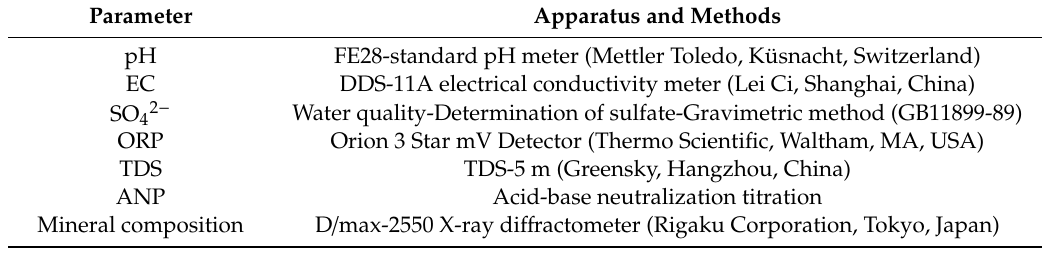
Table 1. The apparatus and methods for detecting pollution indices of leachate.